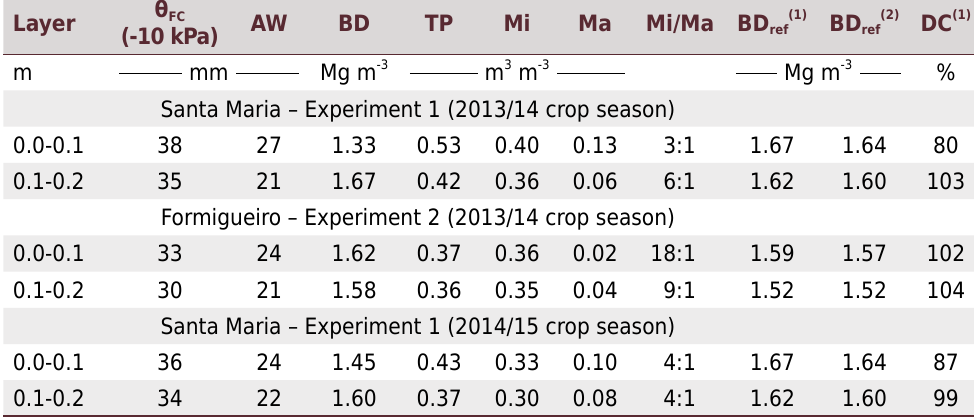
The methods used were according to Donagema et al. (2011). θ FC and AW: determined by Richards extractor device (Soils Moisture Equipment); BD: volumetric method; TP: calculation method with particle density; Mi: tension table method: 0.6 m tension; Ma: difference between TP and Mi. (1) BD ref and DC: determined as proposed by Reichert et al. (2009); and (2) BD ref : as proposed by Jones (1983).